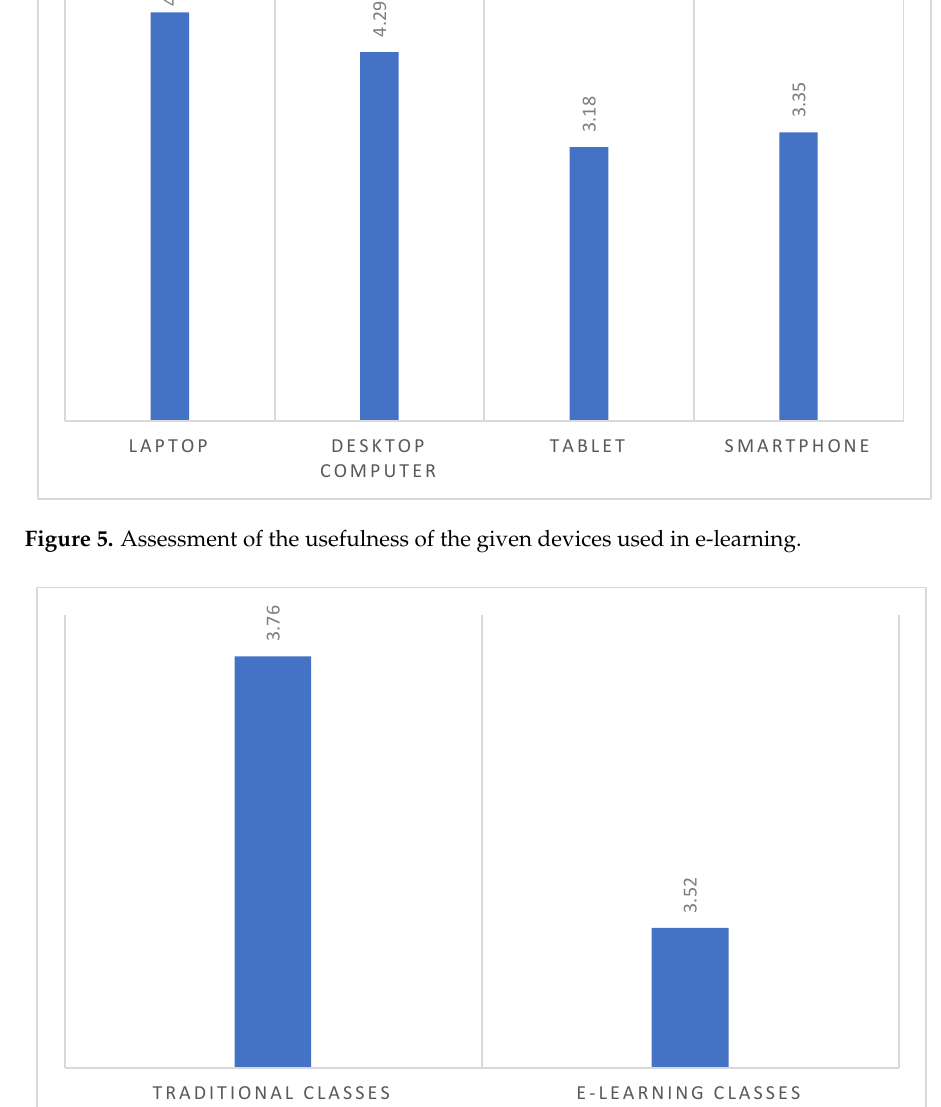
Figure 5. Assessment of the usefulness of the given devices used in e-learning.